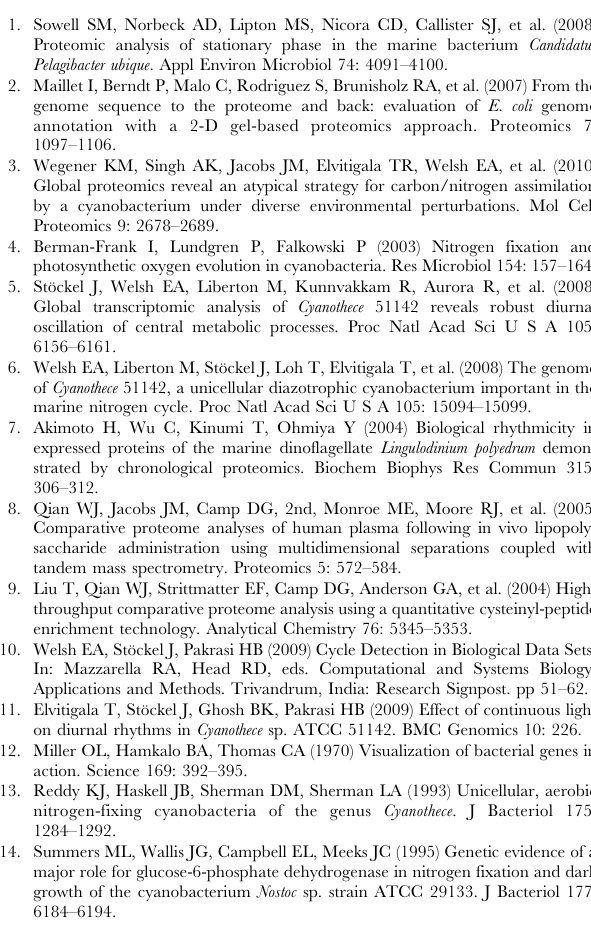
fold-changes are undefined (n.d.), because their minimum spectral count values are equivalent to zero. Table S7 Single-peptide-based protein identifications. The total number of single-peptide-based protein identifications including accession number, protein annotation settings, and pre- MS separations parameters for the LC-MS/MS analyses. The corresponding MS/MS spectra are shown in identical order in Figure